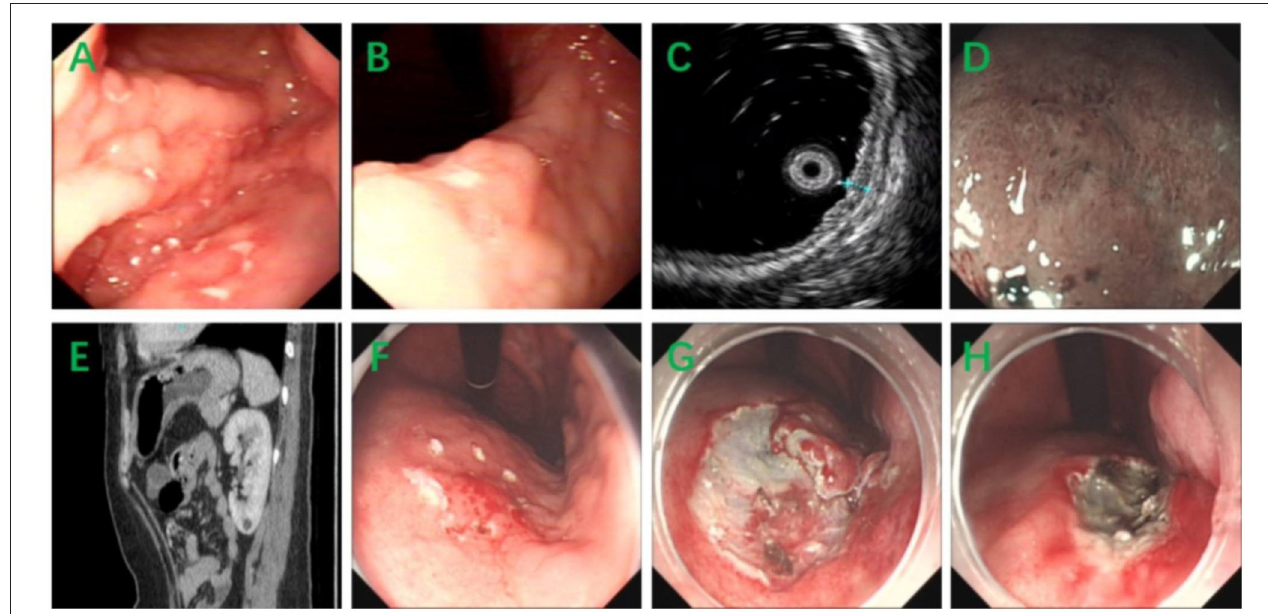
FIGURE 1 | (A,B) Gastroscopy revealed multiple erosion and ulcer in gastric body and gastric angle. (C) EUS revealed hypoechoic thickening of the mucosa layer. (D) ME-NBI showed irregular marginal crypt epithelium and subepithelial capillary network. (E) Abdominal computed tomography showed thickening of the wall of gastric body and gastric fundus and mild enhancement, and the surrounding lymph nodes were enlarged. (F–H) The procedure of